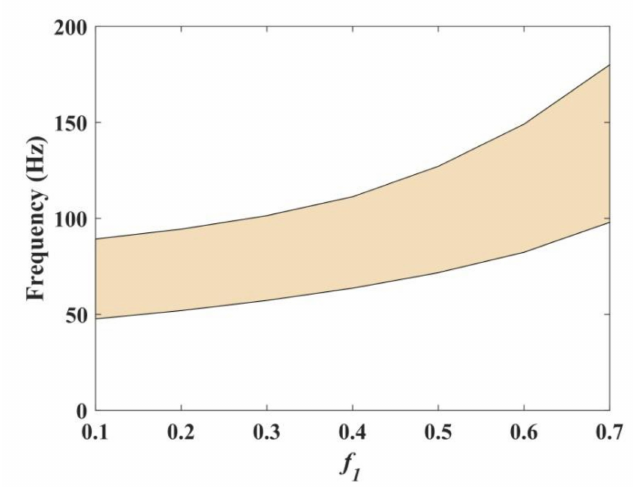
Figure 6. The influence of f 1 on the band gap.